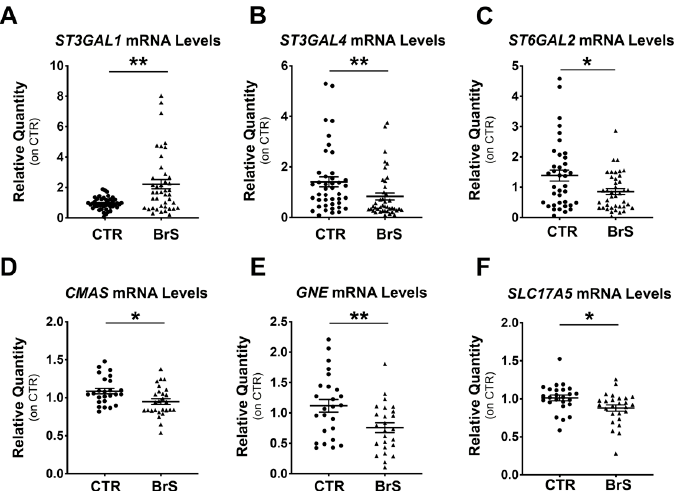
Figure 1. Gene expression analysis reveals dysregulations of sialylation pathway in BrS patients. PBMCs were isolated from healthy subjects (CTR) and BrS patients (BrS) and the expression of six genes involved in the sialylation pathway was evaluated. mRNA expression of ST3Gal1 ( A ), ST3Gal4 ( B ), ST6Gal2 ( C ), CMAS ( D ), GNE ( E ), and SLC17A5 ( F ) through RT-PCR. CTR: N = 42, BrS: N = 42 for ( A – C ). CTR: N = 25, BrS: N = 27 for ( D – F ). Data represent the mean ± SEM and